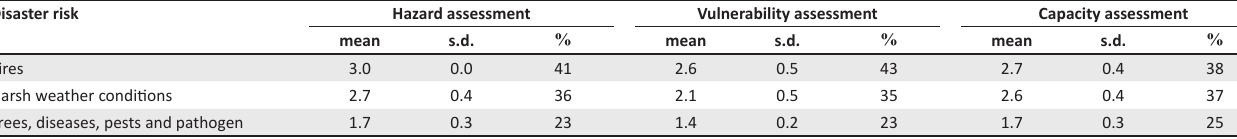
TABLE 1: Hazard, vulnerability and capacity assessment at Roburnia Plantation. Disaster